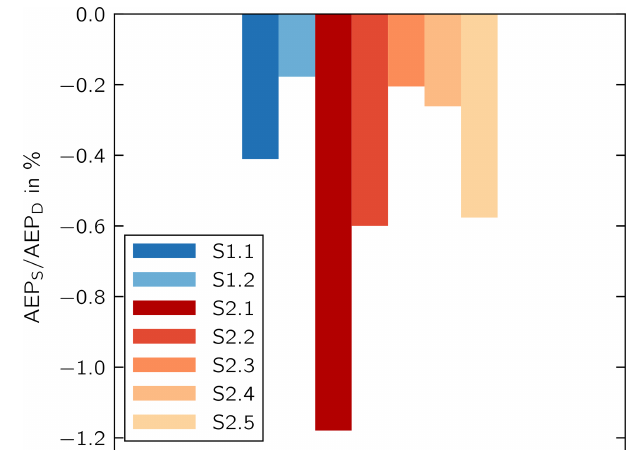
Figure 7. Annual energy production in imbalance scenar- ios (AEP S ) compared to the design situation (AEP D